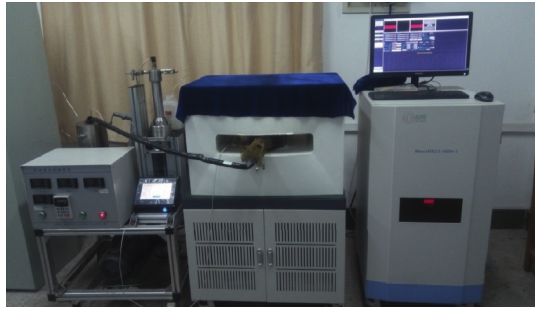
Figure 1: The physical map experimental system. Table 1: Coal basic parameter test.